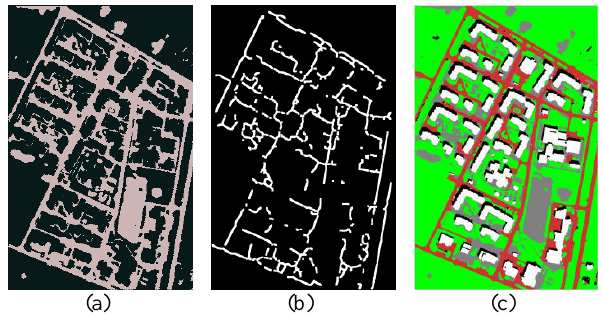
Figure 4. (a) The regions belonging to class others, (b) input for the class road, and (c) the output of Stage III. White, red, green, black, and grey colours indicate the regions for the classes building, road, vegetation, shadow and others,